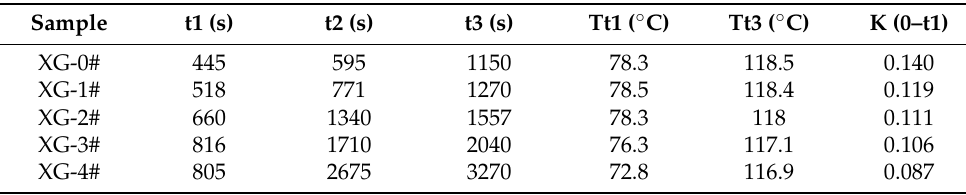
Table 3. The values of t1, t2, t3, Tt1, Tt3 and K(0–t1).